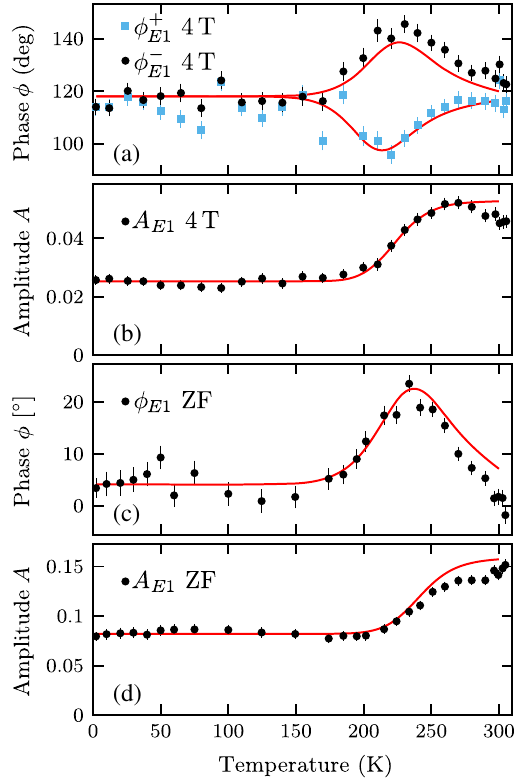
FIG. 7. Comparison of the experimental E 1 phase and ampli- tude with the E 2 → E 1 transition model for (a) ϕ (cid:4) amplitude, as obtained by a shared fit of the f (cid:4) ϕ and (d) ZF amplitude. Solid lines are Eqs. (C2) and (C3) with E 1 shared model parameters E